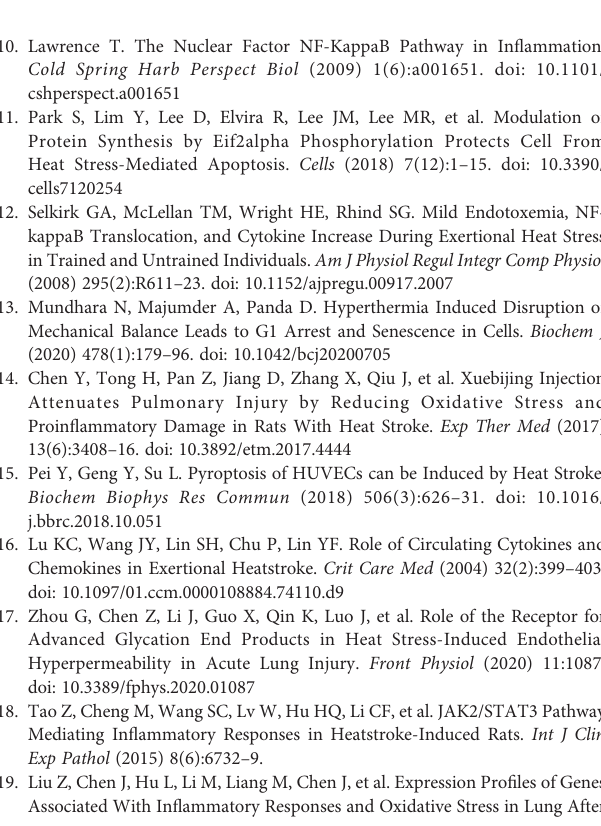
Supplementary Figure 1 | The core temperature of the experimental animals. Body temperature changes in WT and ALDH2*2 KI mice subjected to WBH. Supplementary Figure 2 | Theserum levelsof AST, CK,and BUNinexperimental animals. ALDH2*2 KImice andtheirlittermates (A) and Alda-1-treated mice (B) subjectedtoWBH.Thedataareexpressedasthemean±SD.Statisticalsigni fi canceis indicated as * p < 0.05. Supplementary Figure 3 | Alda-1 increased the ALDH2 activity but not its expression in HUVECs. (A) ALDH2 protein expression was measured by immunoblotting( n = 5). (B) ALDH2 activity was measuredby NADH production as determinedbytheO.D.absorbanceat450nminamicroplatereader( n =5).Thedata are expressedas themean ± SD. Statisticalsigni fi cance isindicated as * p <